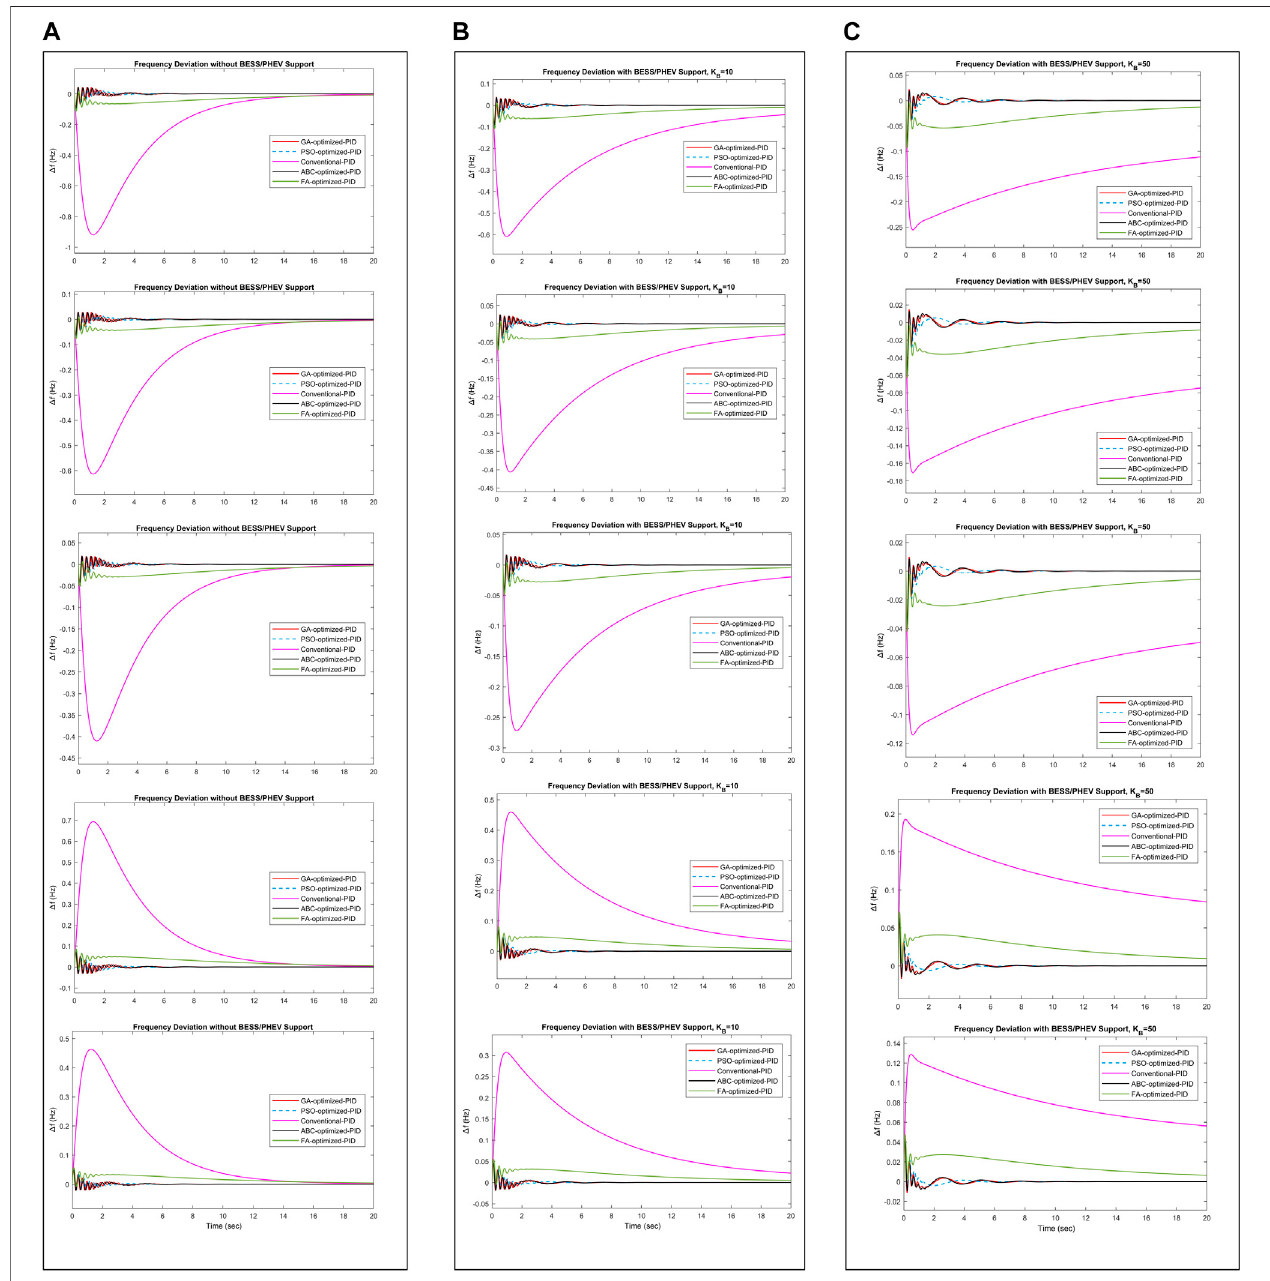
FIGURE 6 | Frequency deviation response using integral square error (A) without BESS/PHEV support (B) with BESS/PHEV support, K B (cid:2) 10 (C) with BESS/ PHEV support, K B (cid:2)